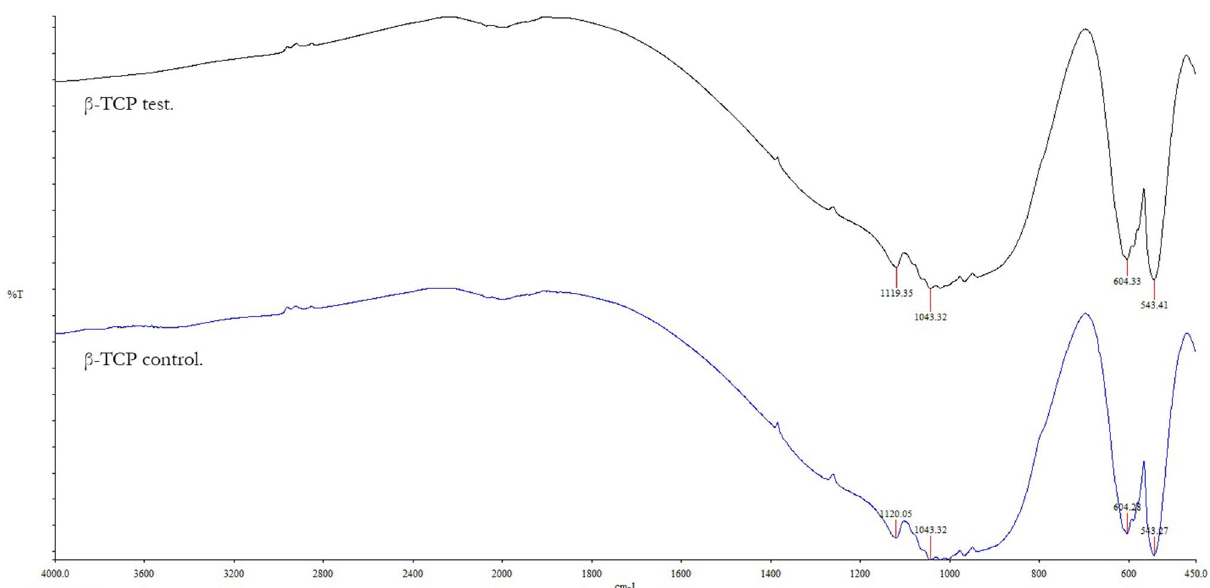
Figure 5. Fourier transform infrared (FTIR) spectroscopy characterization (NICOLET iS50, Thermo Scientific, Madison, USA). FTIR spectra of both β-TCP test and β-TCP control have the same absorption peaks, corresponding to phosphate band